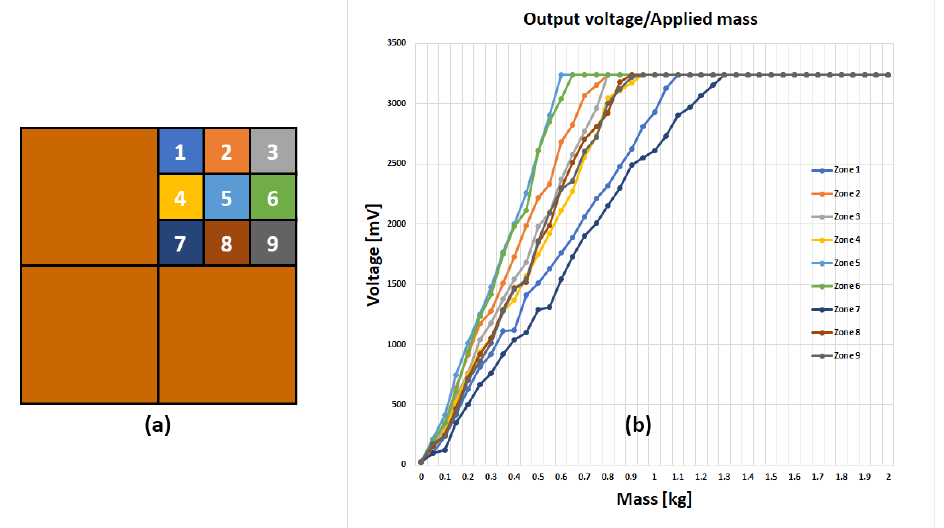
Figure 10. Representation of the smart tile with one quarter subdivided into nine different zones ( a ). Measures of the analogue output voltage, depending on mass and position ( b ).